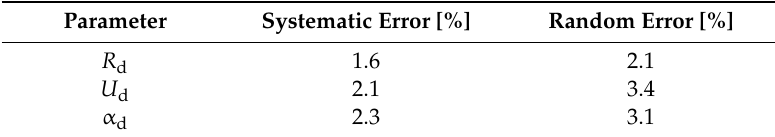
Table 3. Systematic and random errors in determining the parameters.